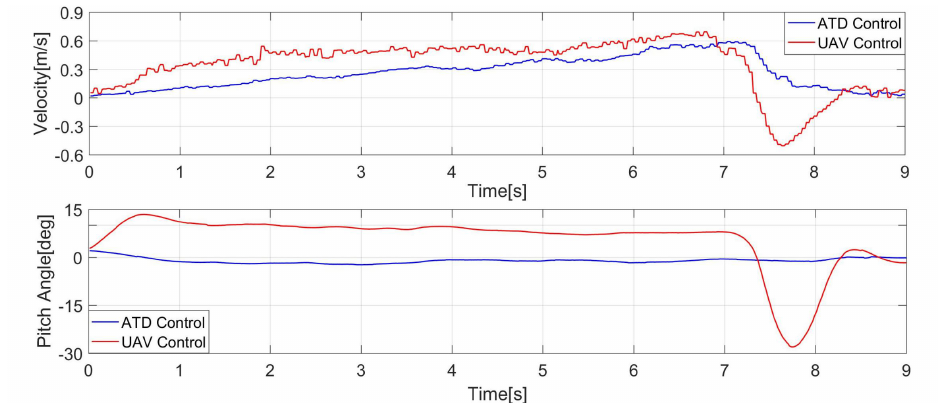
Figure 7. Experimental results of the ATD control and multirotor control. The result was recorded from the start of multirotor translating until it stopped: (top) the velocity change of the multirotor in y axis; and (bottom) the pitch angle change.